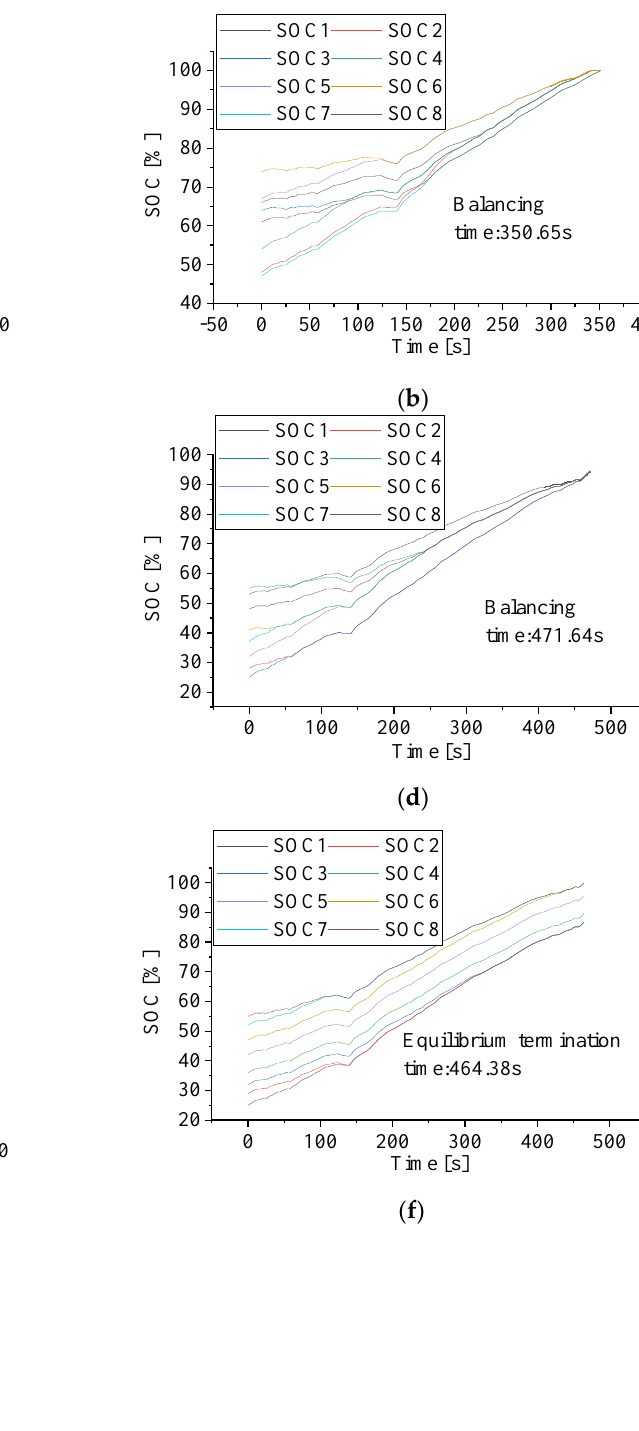
Figure 19. ( a ) case l multi-layer equilibrium, ( b ) case 1 adjacent equilibrium, ( c ) case 2 multi-layer equilibrium, ( d ) case 2 adjacent equilibrium, ( e ) case 3 multi-layer equilibrium, ( f ) case 3 adjacent equilibrium, ( g ) case 4 multi-layer equilibrium, ( h ) case 4 adjacent equilibrium. 5.6. Overall Analysis The performance of the equalization method tested is shown in Table 5. When the multi-layer equalization circuit does not use the equalization method, the equalization time is 245.7 s and the maximum battery current is 5.04 A, which is significantly more than the 3 A allowed by this study. The proposed equalization method has a time of equaliza- tion of 268.5 s and a maximum current of 3 A, which is within the allowable range. The equalization time is 350.65 s and the maximum current is 4.93 A when the adjacent battery equalization circuit is used and the equalization strategy is not applied, surpassing the maximum permitted current. The battery pack did not reach equalization using the fuzzy control equalization approach, and the highest equalization current was 4.72 A. Despite the fact that the current was lowering, it was still above the limit. The battery pack did not attain equilibrium using the control approach based on SOC difference, and the maximum equilibrium current was 4.68 A, surpassing the maximum permitted current. To summa- rize, the proposed layered control method based on multi-layer equalization circuit can take use of the multi-layer equalization circuit’s high equalization speed while keeping the battery current within the permissible range, which ensures both the equalization speed and the safety of the equalization process. Table 5. Comparison of equilibrium results. Equalization Circuit